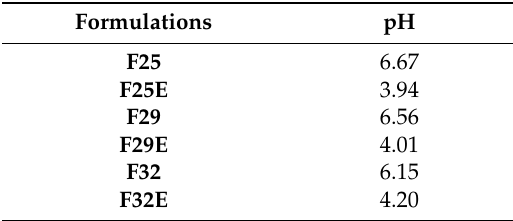
Table 4. pH of the